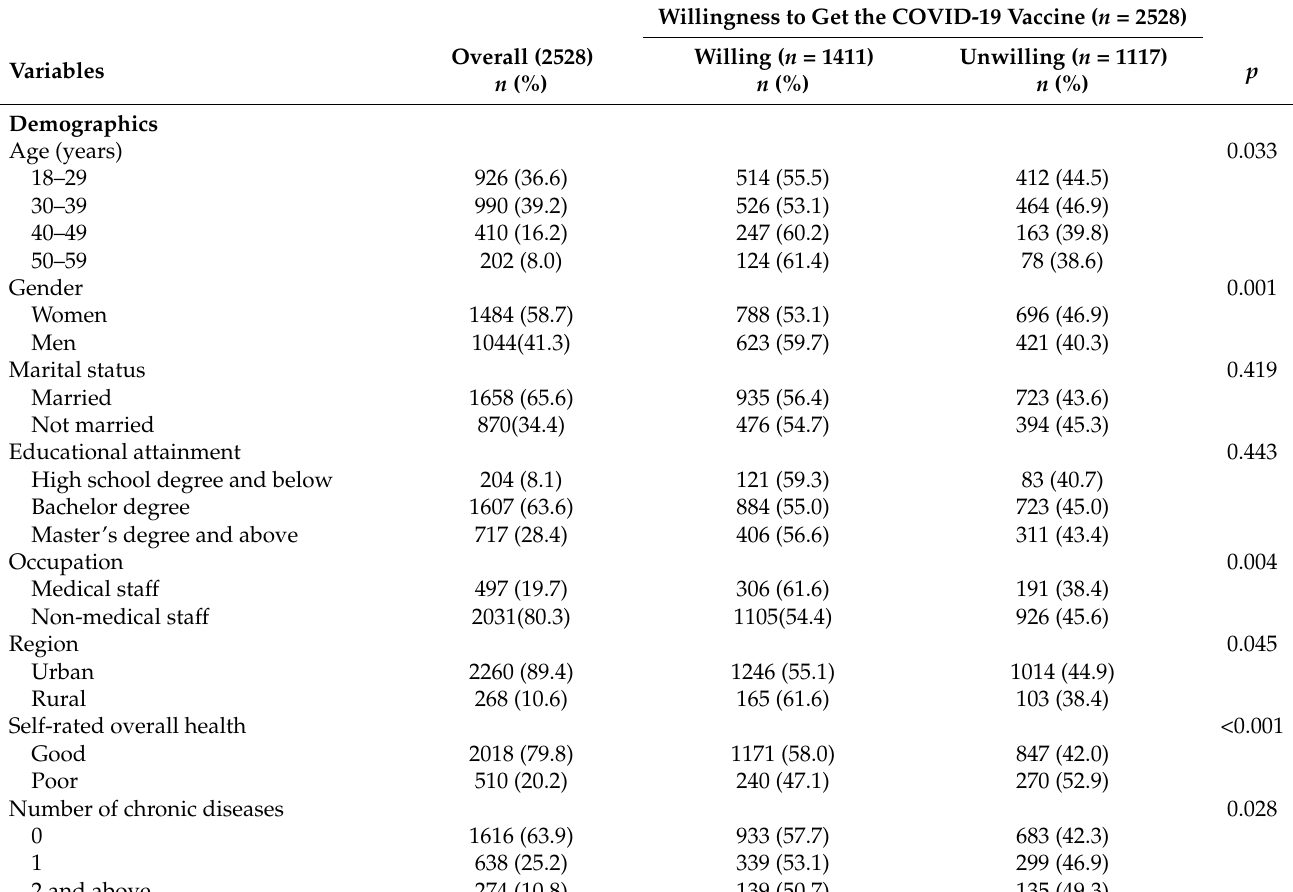
Table 2. Descriptive statistics of 2528